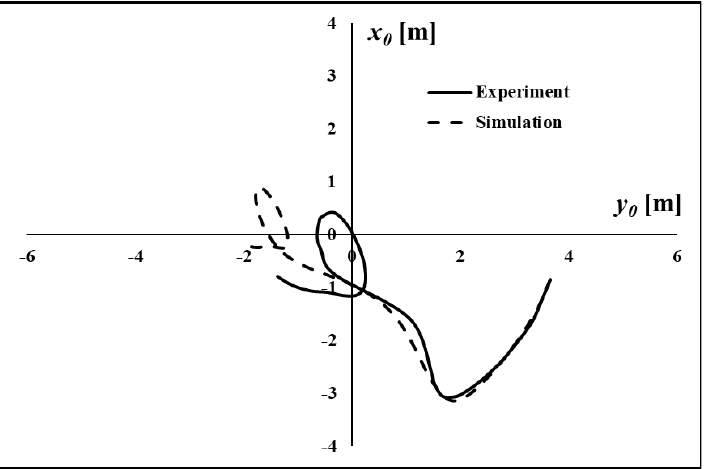
Figure 22. Comparison of experiment and simulation at P6.